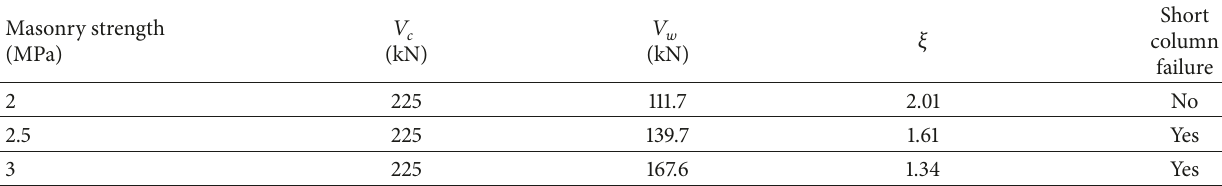
Table 5: Shear bearing capacity ratio of the frame column to the infill wall ( 𝜉 ).